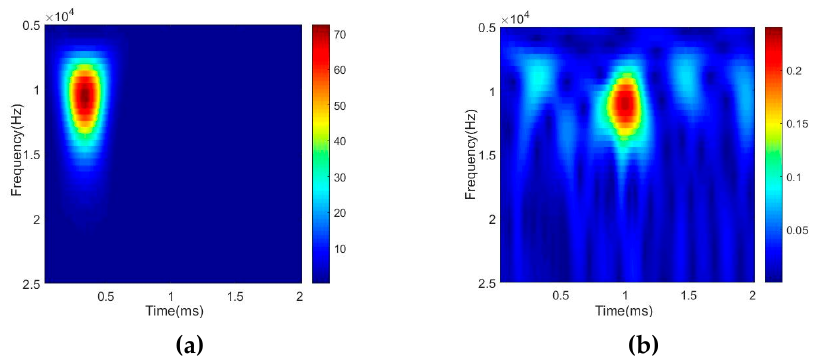
Figure 11. Energy spectra of ( a ) Lamb wave excitation signal E (t) and ( b ) damage-scattered signal S (t).